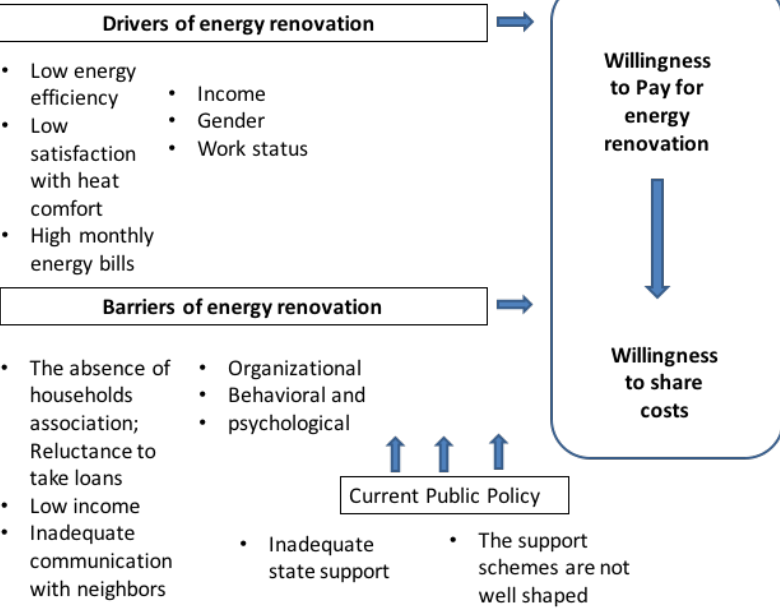
Figure 1. Results of the study.